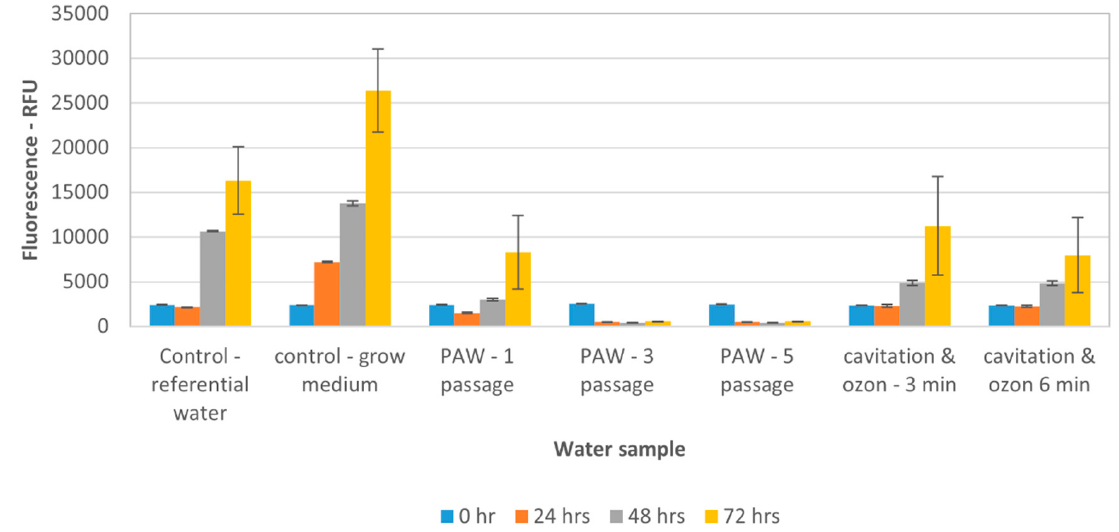
Figure 8. Growth of algae in water samples treated by HCPJ (PAW), and cavitation with ozonisation over time (0 h, 24 h, 48 h, 72 h). Fluorescence measurements are given in relative fluorescence units (RFU).